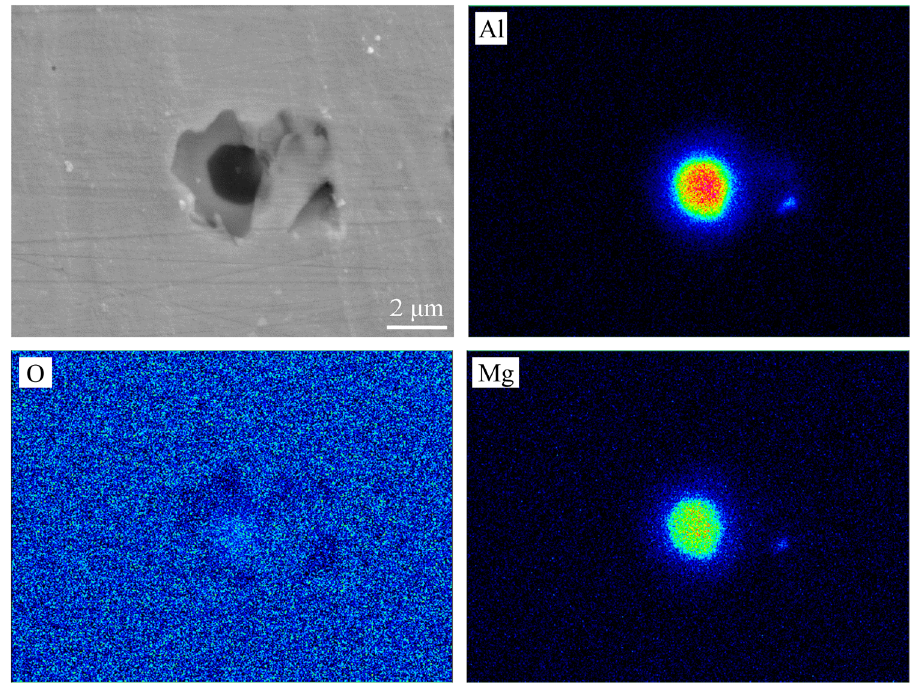
Figure 9: Images of pit morphologies in FSS1 after potentiostatic polarization in 10% NaCl